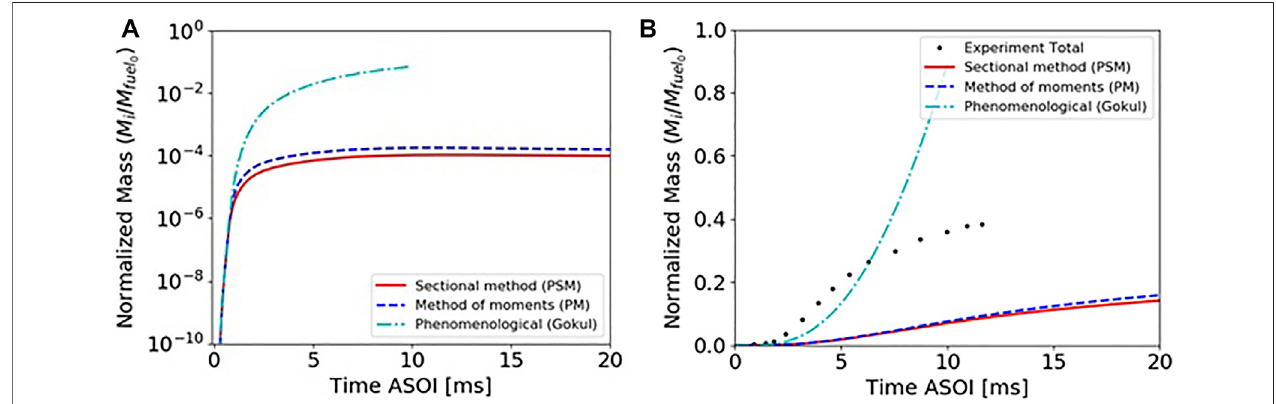
FIGURE4| (A) Time-resolved pro fi lesofthemass ofpyrene normalized bythe massofinjected fueland (B) total soot mass pro fi les normalized bythe injected fuel mass predicted by different soot models using the Wang et al. (2014) mechanism, and compared to the experimental data of Skeen and Yasutomi (2018).